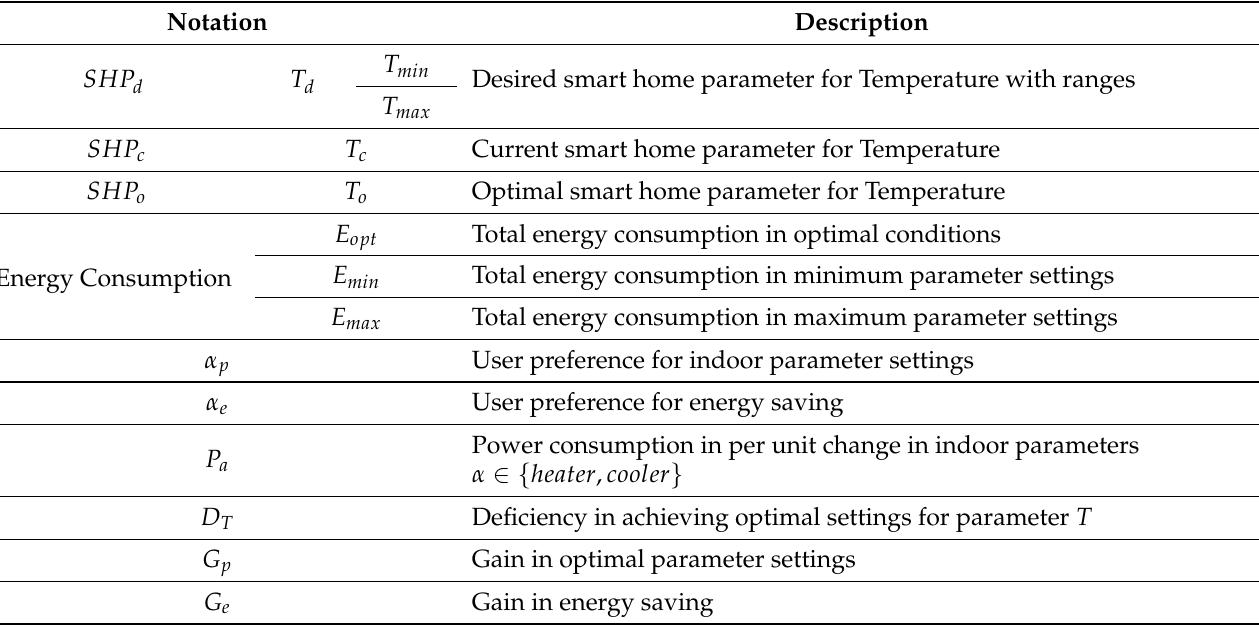
Table 2. Proposed Objective Function